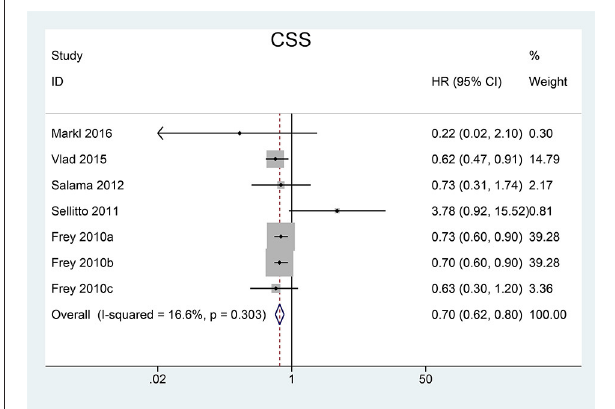
FIGURE 2 | Forest plot of the HR for the association between FoxP3 + Tregs and CSS in patients with CRC. Frey et al. (2010) are for MMR-deficient group, MMR-proficient Test Group 1, and MMR-proficient Test Group 2, respectively. HR = 0.70, 95% CI = 0.62–0.80, P < 0.001, fixed model. FoxP3, Forkhead box P3; Tregs, regulatory T lymphocytes; CRC, colorectal cancer; CSS, cancer-specific survival; MMR, mismatch-repair; HR, hazard ratio; CI, confidence